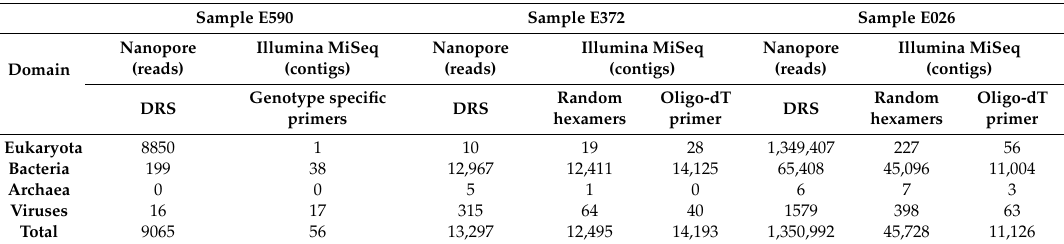
Table 1. Taxonomic classification of reads (Oxford Nanopore) and contigs (Illumina MiSeq). BLASTN matchesagainsttheNCBI’snucleotide( nt )databaseweresummarizedatthedomainlevelwithMEGAN. Sample E590 Sample